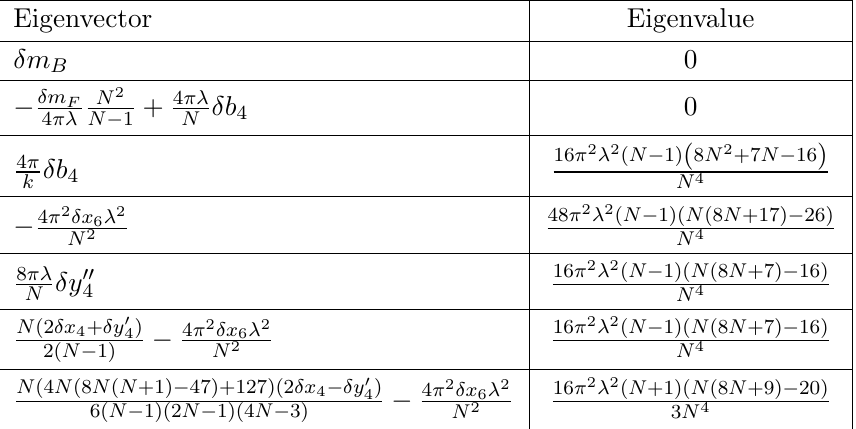
= 2 SU( N ) superconfor- N